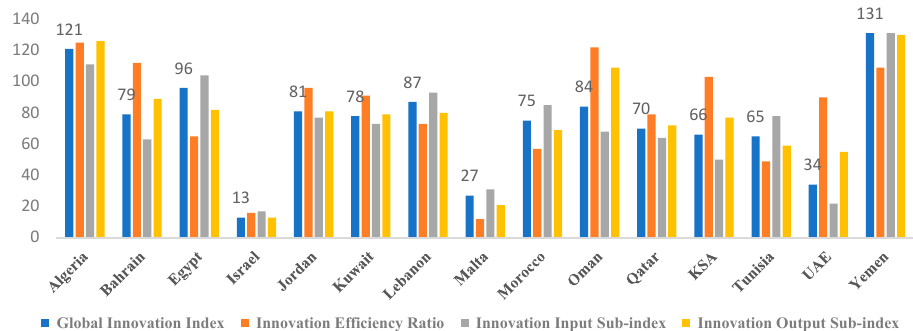
Figure 2. Innovation index for Middle East and North Africa (MENA) region based on GII 2020. Source: author calculations, from GII database (2020) (retired 18/12/2020 from https://www.globalinnovationindex.org/analysis-indicator).